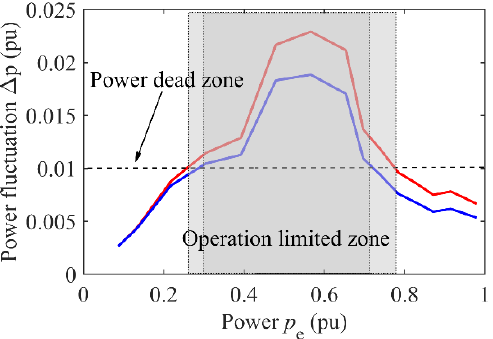
Figure 7. Operation limited zone with different controls.